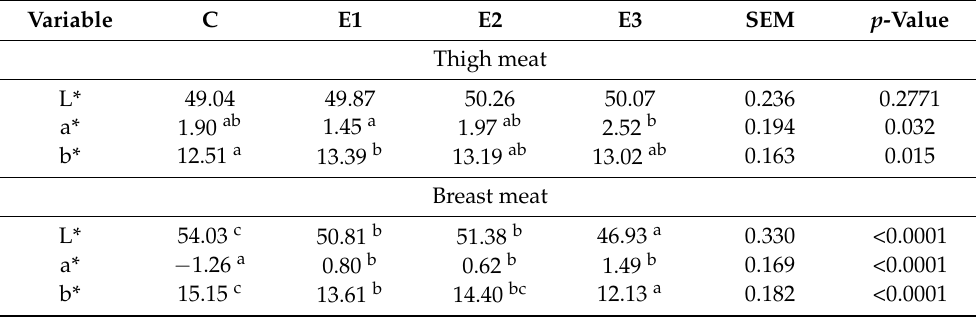
Table 4. Color parameters of the chicken